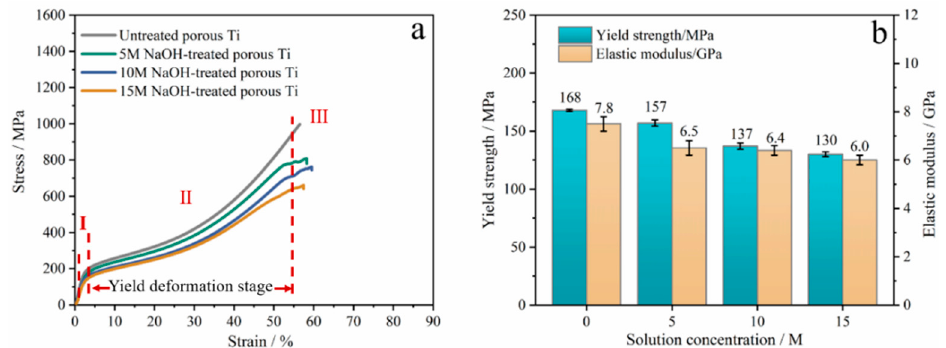
Figure 8. Compressive stress–strain curves, yield strength, and elastic modulus statistics of porous titanium treated with different concentrations of NaOH solution. ( a ) Compressive stress-strain curves of porous titanium treated with different concentrations of NaOH, ( b ) Compressive yield strength and elastic modulus histogram of porous titanium treated with different concentrations of NaOH.